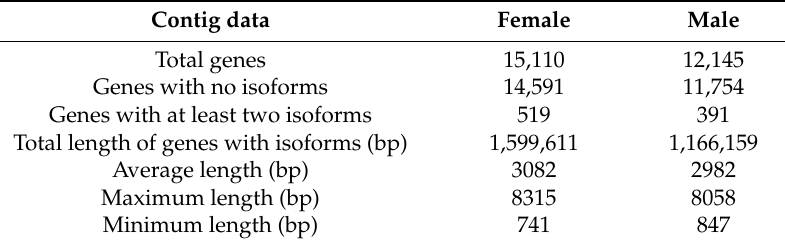
Table 3. Summary of the isoform information for Haliotis discus hannai